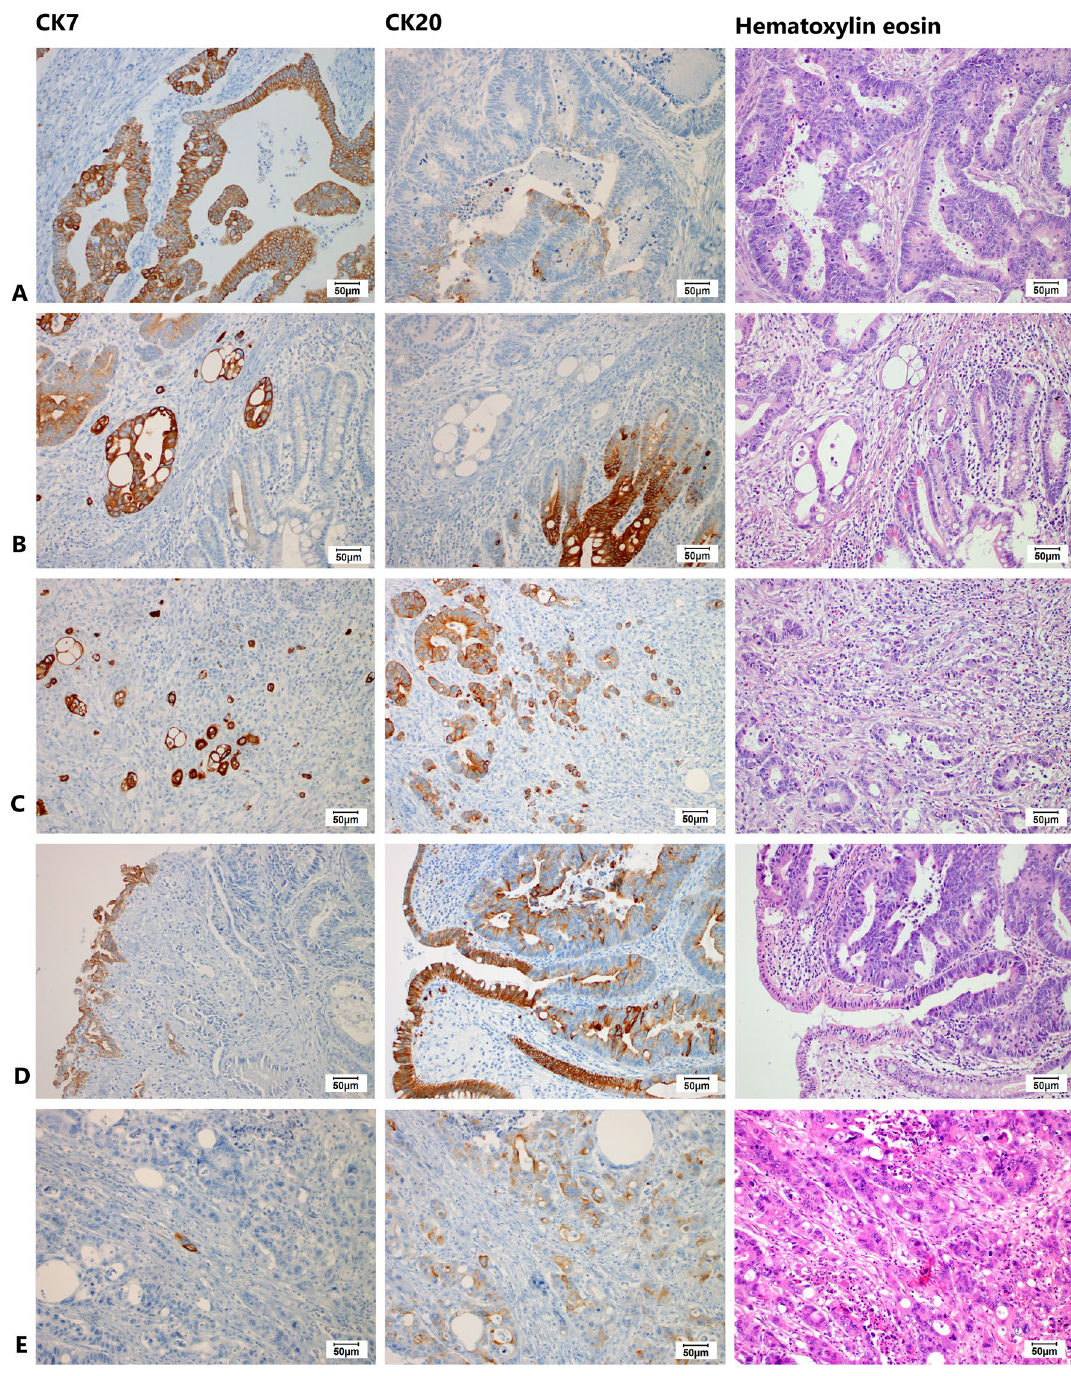
Figure 1. Histological images (magnification 200x) showing: ( A ) diffusely strongly CK7 + adenocarcinoma with a weak focal CK20 staining regarded as CK20- tumor; ( B ) diffusely strongly CK7 + and CK20- adenocarcinoma of cecum infiltrating CK7-/CK20 + non-neoplastic mucosa; ( C ) tumor budding cells with strong CK7 + / CK20 + ; ( D ) adenocarcinoma showing moderate CK7 + in ca 20% of cells and CK20 + in ca 80% of cells; ( E ) adenocarcinoma with CK7 expression in isolated single cells (< 1%), and weak CK20 staining in ca 40% of cells, regarded as CK7-/CK20 + . The hematoxylin eosin images document glandular arrangement of colorectal adenocarcinoma, in line c with tumor